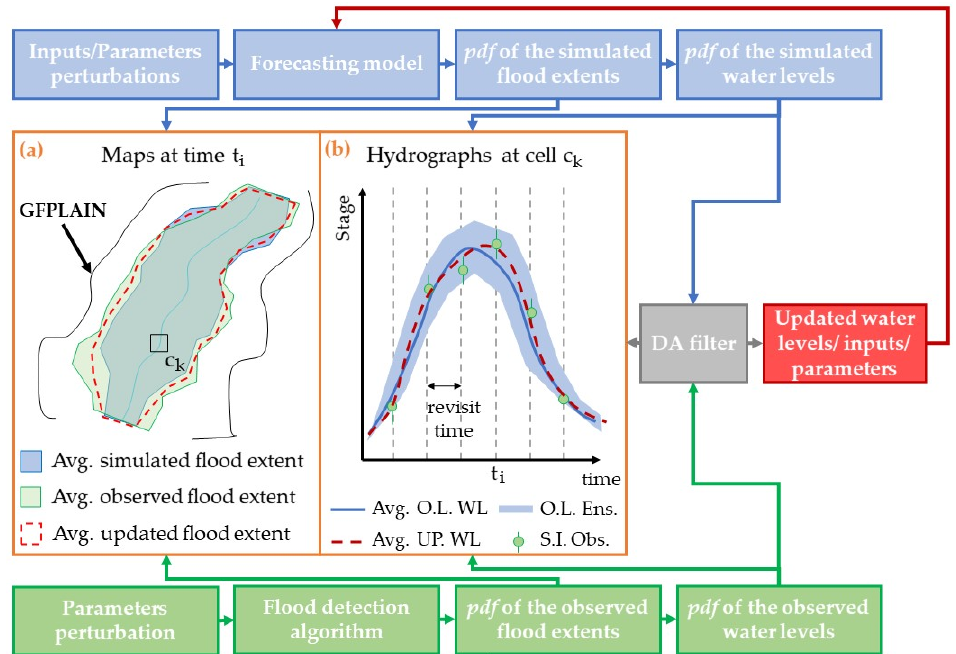
Figure 4. Scheme of a DA framework for flood forecasting updated by satellite-derived flood extents observations (S.I. Obs). The upper blue boxes illustrate the generation of the probability density function (pdf) of the simulated water levels/extents of the forecasting model. The lower green boxes represent the generation of the pdf of the observed water levels/extents from the satellite imagery. The two abovementioned pdf are combined with a Data Assimilation filter (Grey box, e.g., EnKF or PF) to produce the updated water levels and/or model inputs and/or model parameters (red box). The central orange boxes schematize ( a ) the comparison between the average observed and simulated flood extents (both bounded by the GFPLIN dataset) at a specific time step t i ; ( b ) the hydrograph, at a specific cell (c k ) of the average (Avg. O.L. WL) and the ensemble spread (O.L. Ens.) of water levels for the open loop (blue line) generated by the forecasting model before the assimilation step and the hydrograph of the average updated water levels (Avg. UP. WL—Dashed red line) after the assimilation step.